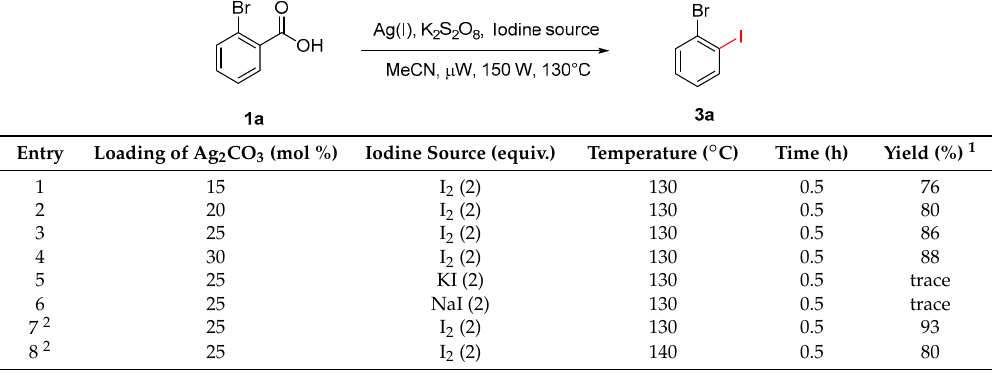
Table 2. Selected results for the optimization of decarboxylative iodination conditions.